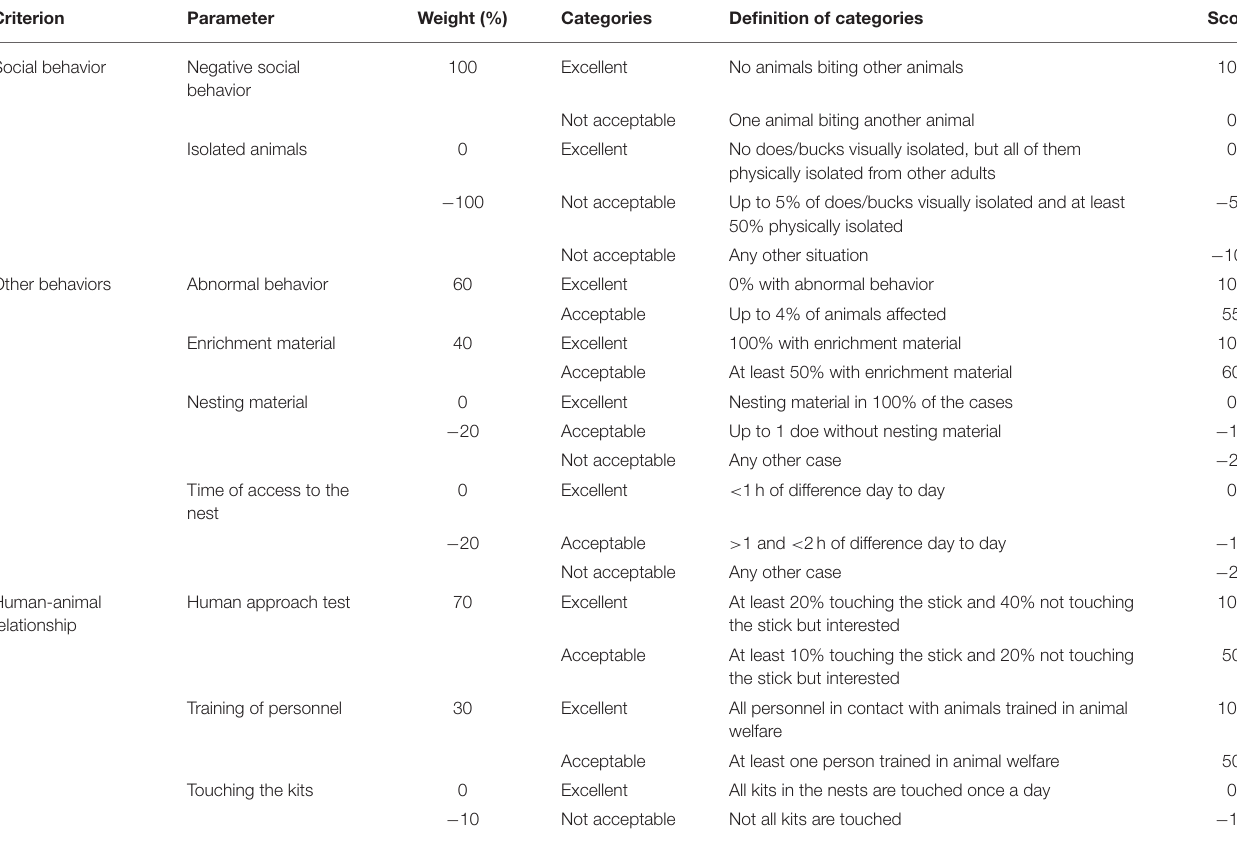
TABLE 5 | Parameters used to assess the criteria of social behavior, other behaviors and human-animal relationship.